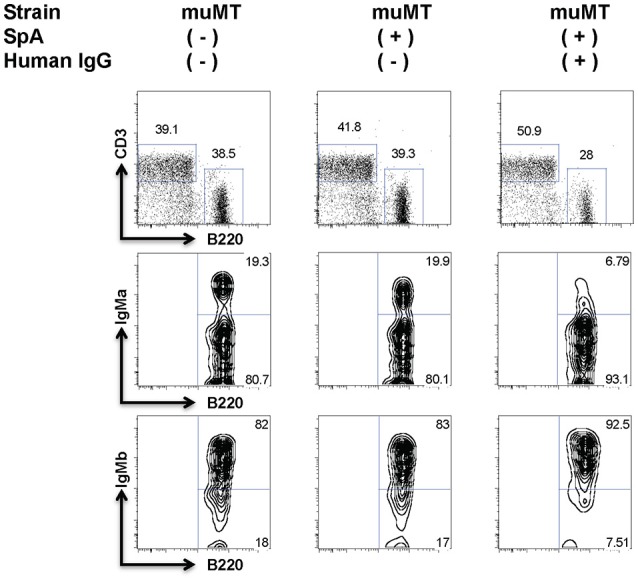
Soluble IgG is essential for the BCR targeted in vivo deletion induced by SpA. B-cell deficient (muMT) mice received adoptive transfer of T15i B cells, and after sham or human polyclonal IgG pretreatment were later challenged with PBS or SpA. Results represent residual splenic B220+ IgMa + B cells, after flow cytometric gating on adoptively transferred CFSE-labeled mononuclear cells, which omits CD3+ cells. Treatment with hu IgG alone had no effect (not shown). Gating strategy was used to quantitate values shown in Figures 3, 5.